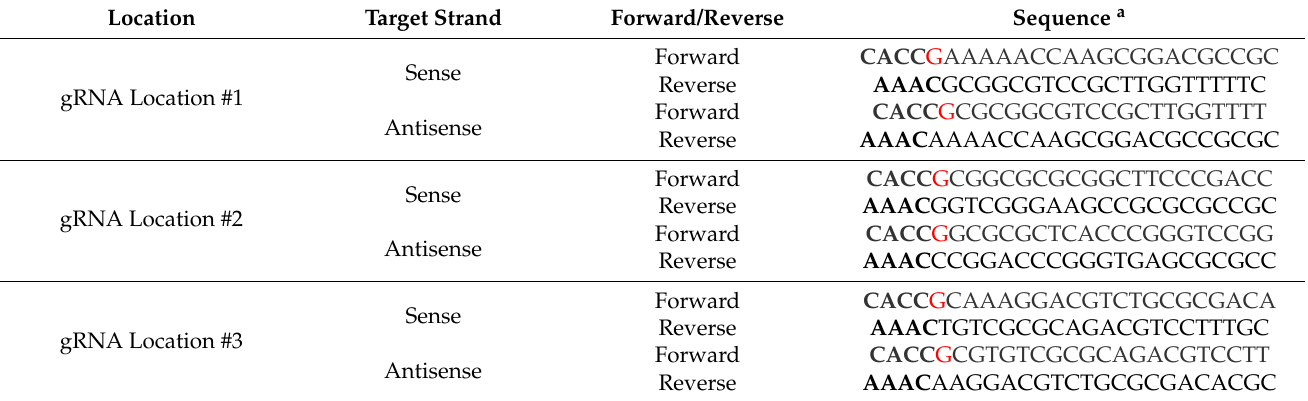
a Added 5 (cid:48) guanine residues are highlighted in red; overhang sequences for cloning are highlighted in